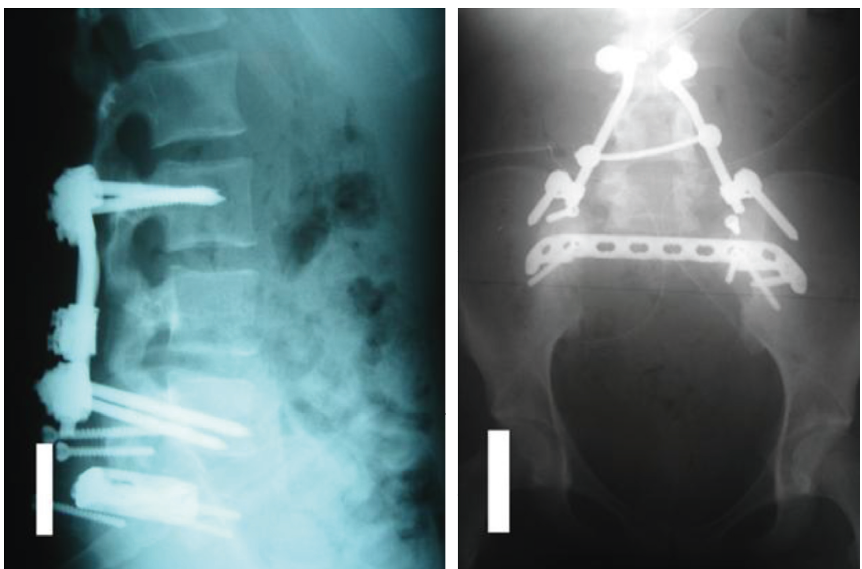
Figure 5: Postoperative X-rays of the lower spine in two axes (AP and lateral).